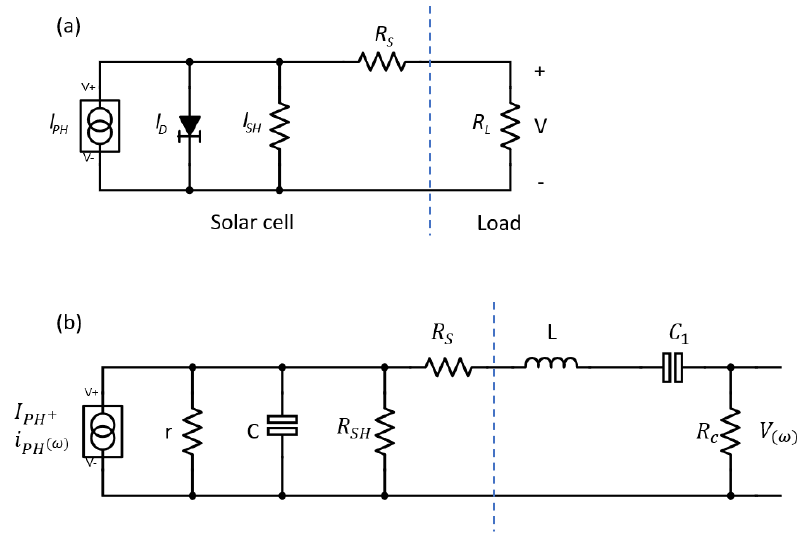
Figure 2. Solar panel circuit model for ( a ) energy harvesting and ( b ) information